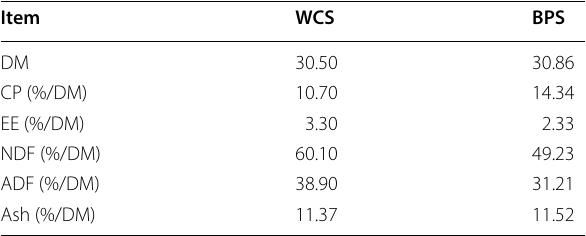
Table 1 Chemical composition of WCS and BPS